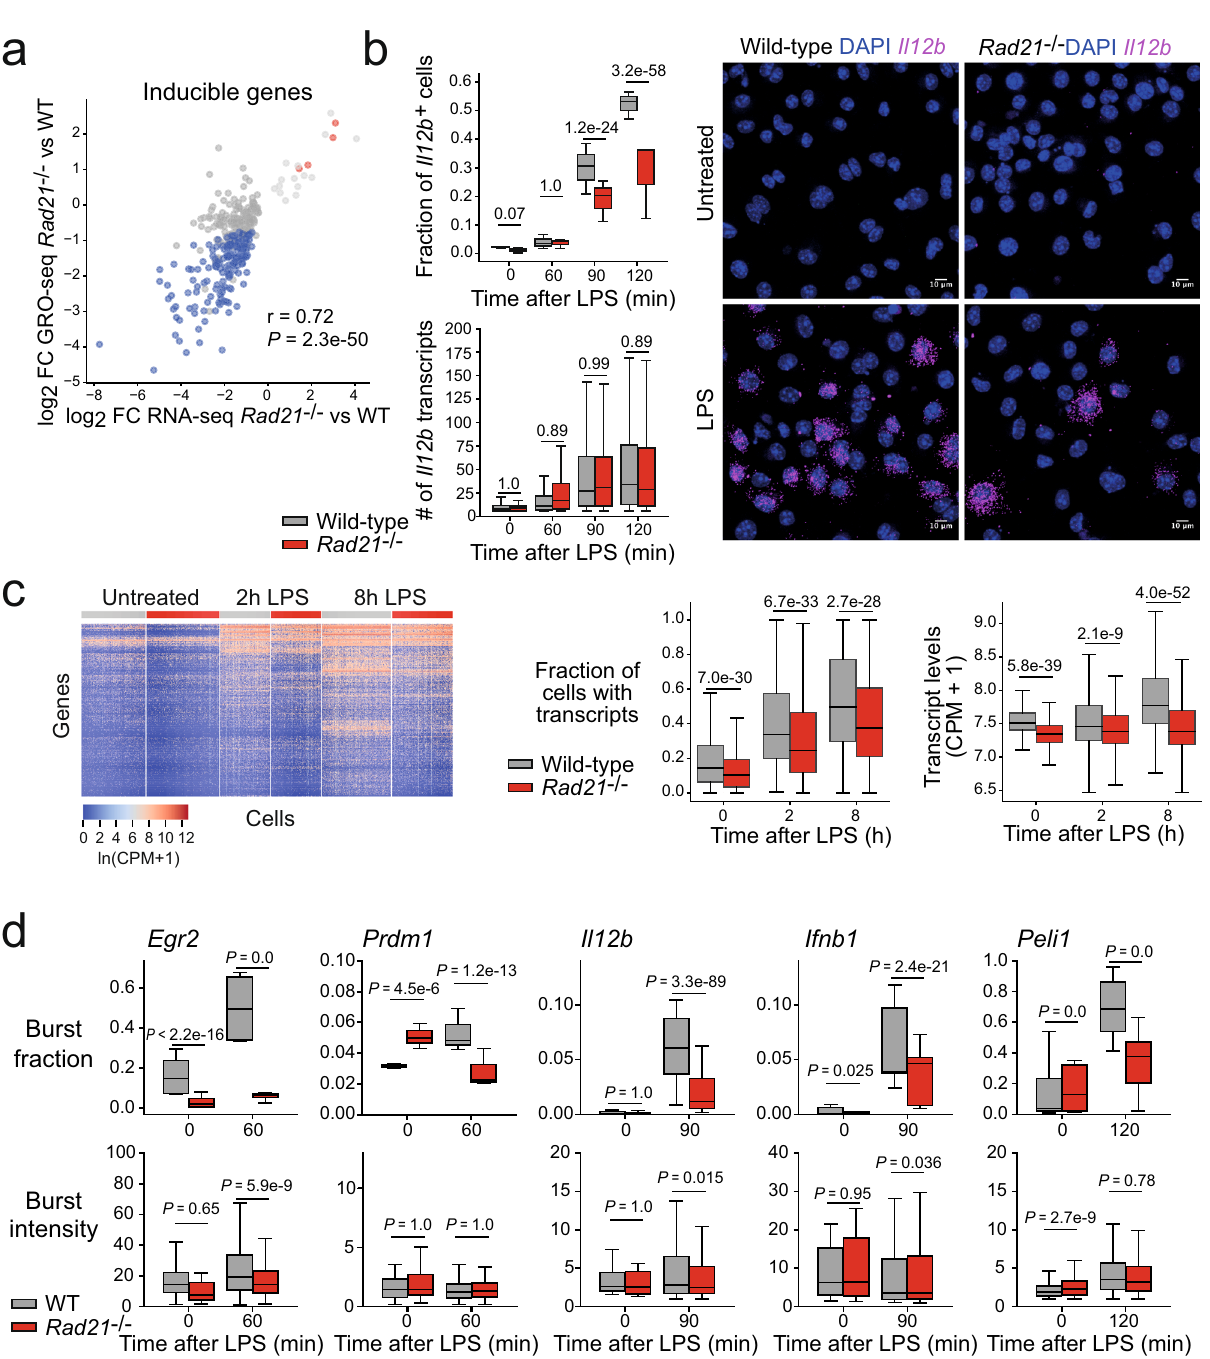
Time after LPS (min) Fig. 5 Deregulation of inducible genes in the absence of cohesin is due primarily to a reduced probability of transcription. a Loss of cohesin alters the expression of inducible genes at the transcriptional level. One hour LPS for GRO-seq, 2 h LPS for RNA-seq. r Pearson correlation. Two-sided Pearson's product-moment correlation (null hypothesis: correlation = 0). Three biological replicates for RNA-seq and two biological replicates for GRO-seq. b The fraction of cells expressing Il12b by smRNA-FISH (top left) and the number of transcripts per cell (bottom left) are plotted for cells expressing at least fi ve transcripts at the indicated time points after LPS activation of wild-type and Rad21 − / − macrophages. Numbers represent adjusted P values. Wilcoxon signed-rank test with Bonferroni correction for multiple testing. Example images are shown on the right. N = 40,941 cells, four independent biological replicates. c Left: heatmap of inducible macrophage genes 30 detected by scRNA-seq in at least 20% of wild-type (grey) or Rad21 − / − macrophages (red). Middle: Fraction of cells with detectable transcripts for inducible genes. Right: The expression level of LPS-inducible transcripts in cells with detectable transcripts is plotted as ln(CPM + 1). Numbers represent adjusted P values. Two-sided Wilcoxon signed-rank test with Bonferroni correction for multiple testing. N = 1362 cells. d Burst fraction and burst intensity measurements for inducible immune genes in wild-type (black) and Rad21 − / − macrophages (red). N = 11,8058 cells, 3 – 7 independent biological